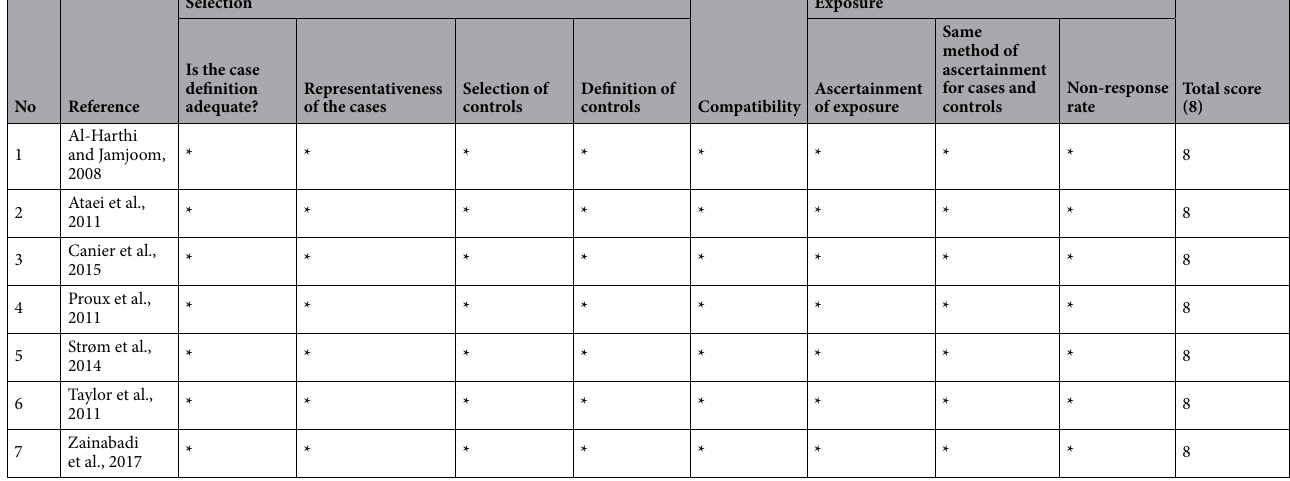
Table 2. Quality of the included studies. * A star rating